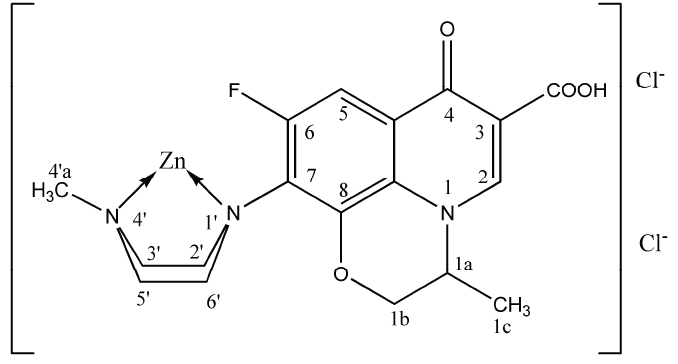
Figure 10. Proposed structure for Zn(II)-levofloxacin